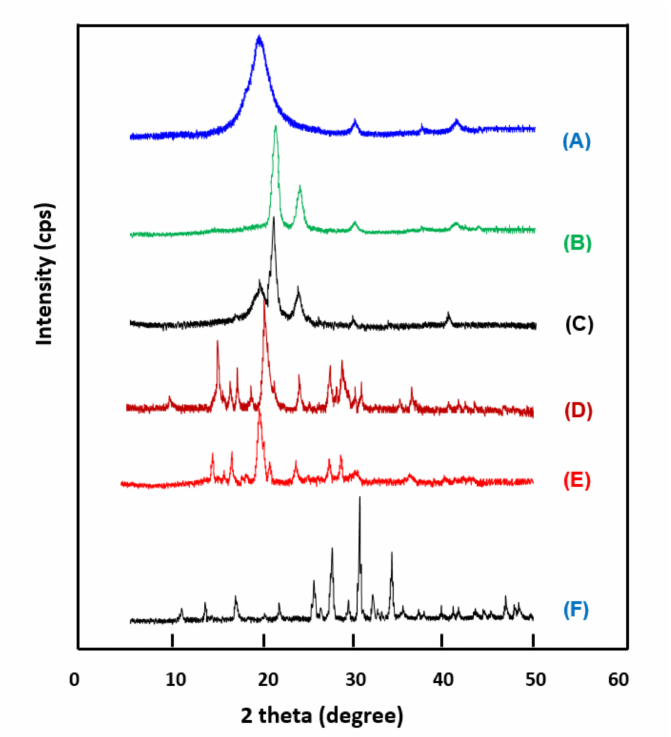
Figure 2. X-ray diffraction (XRD) patterns. ( A ) PEVAL; ( B ) PDVAL; ( C ) PEVAL/PDVAL; ( D ) PEVAL/ PDVAL/ β -TCP50; ( E ) PEVAL/PDVAL/ β -TCP70; ( F ) pure β